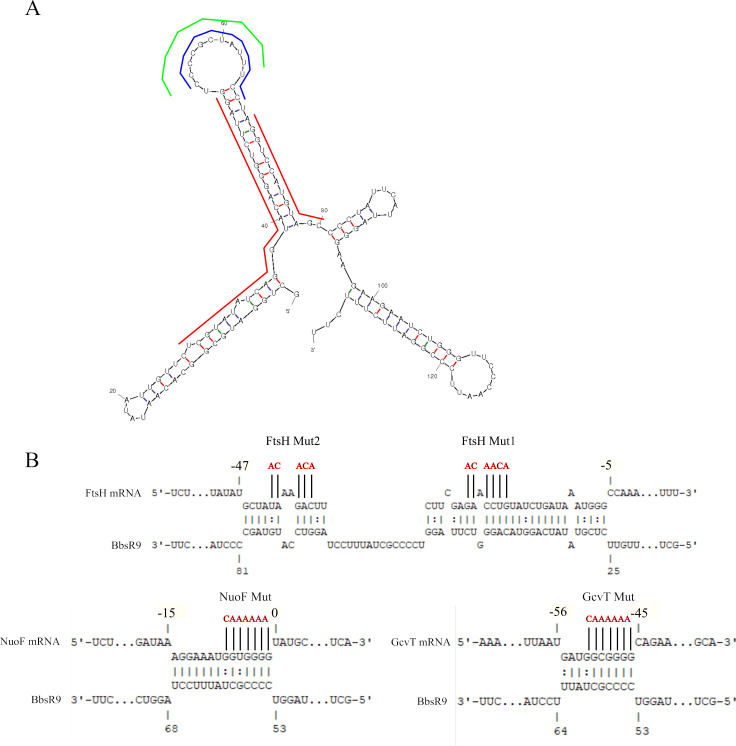
BbsR9 binds its targets through several GC-rich predicted seed regions.A) Mfold secondary structure prediction of BbsR9 (ΔG = -46.9 J mol-1) with predicted seed regions for ftsH, nuoF, and gcvT transcript binding indicated by red, blue, and green lines, respectively. B) Predicted IntaRNA BbsR9 target seed regions of the indicated transcripts. For the mRNA targets, nucleotide position +1 represents the first nucleotide of the respective start codon. Mutagenized bases of each mRNA are indicated in red.